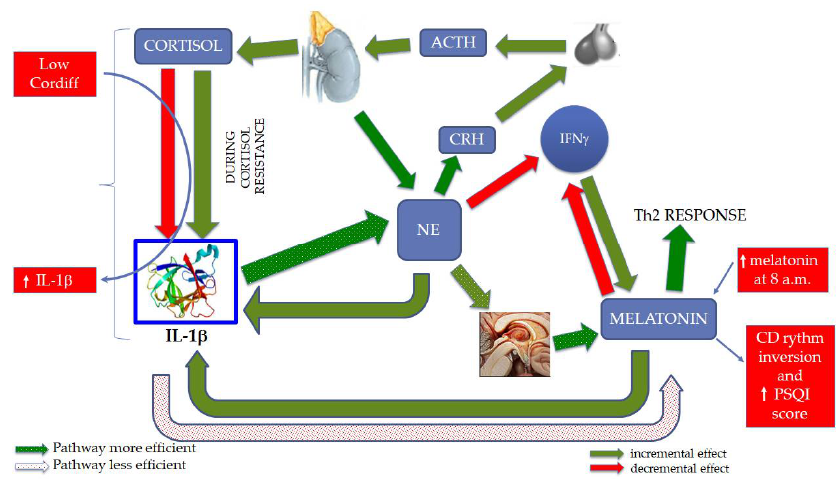
Figure 5. Verification of our hypothesis of the relationships between cortisol, IL-1 β , and melatonin. Results obtained in a fishermen cohort subjected to chronic stress show that low Cortdiff is associated with higher IL-1 β levels, while increased melatonin levels at 8:00 a.m. are associated with circadian (CD) inversion and higher PSQI scores, i.e., sleep disturbances. The dotted arrows hypothesize the relationship between increased IL-1 β levels, NE, and melatonin occurring in fishermen, in particular the more efficient pathway stemming from IL-1 β , increasing NE and, eventually, melatonin. This pathway would overcome the less efficient direct inhibitory pathway of IL-1 β on melatonin. Other abbreviations: norepinephrine (NE); interferon gamma (IFN γ ); T helper 1 (Th1); T helper 2 (Th2); corticotropin releasing hormone (CRH); adrenocorticotropic hormone (ACTH); interleukin 1 β (IL-1 β ); circadian rhythm (CD); Pittsburgh Sleep Quality Index (PSQI); the difference between cortisol